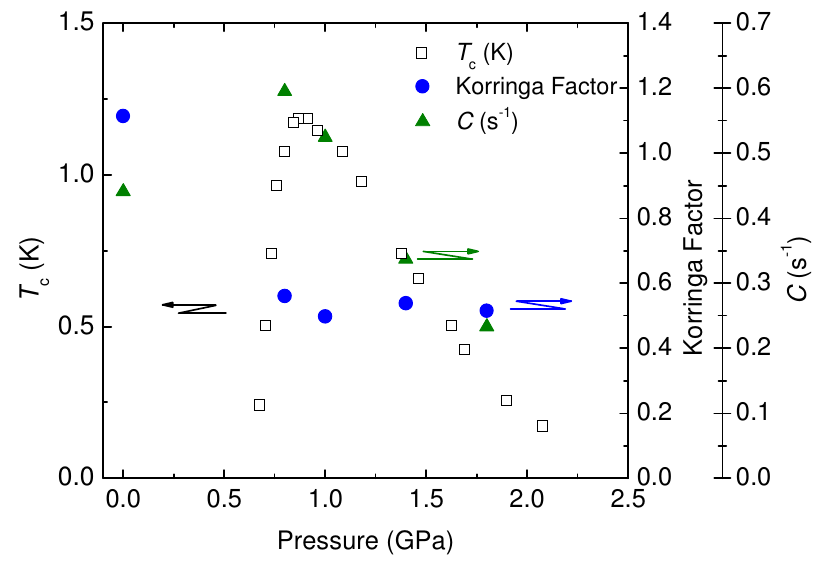
Figure 9. Pressure dependence of superconducting transition temperature, T expression fitting parameter, C , and the Korringa factor